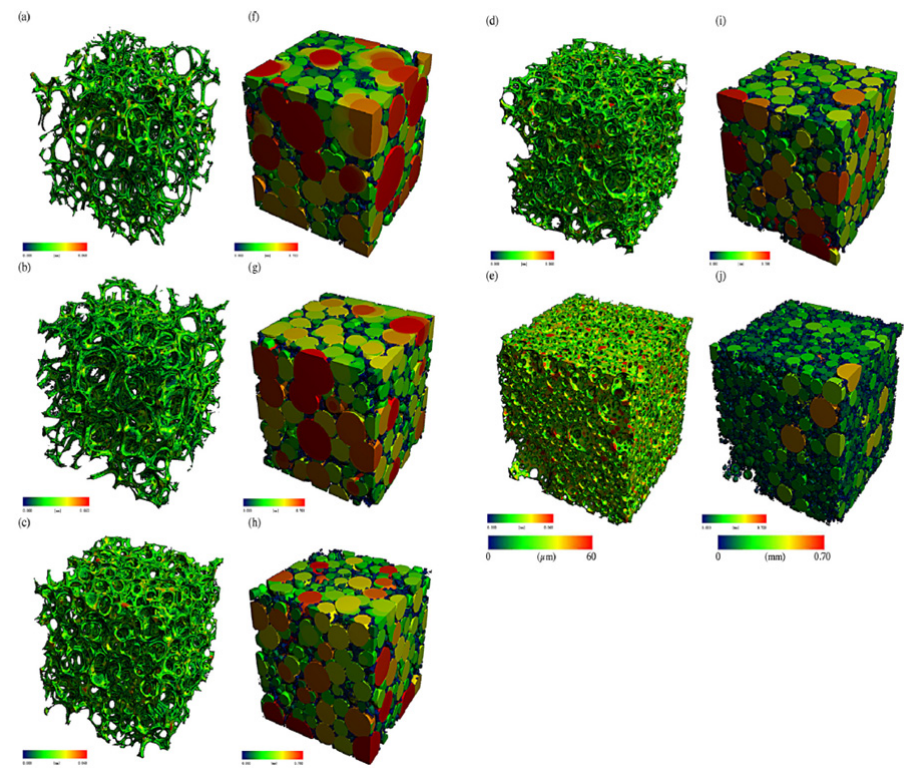
Figure 12. X ‐ ray μ CT imaging of varying concentration foams showing the solid backbone (left) and cells as seen from the solid bodies (right) as a function of % tannins; ( a )/( f ) 39%; ( b )/( g ) 35%; ( c )/( h ) 40%; ( d )/( i ) 45%; ( e )/( j ) 50% [84].